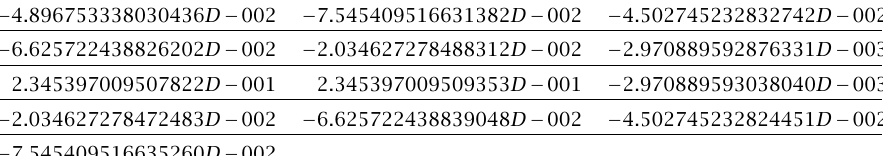
Table 3.9 . The charge distribution with n = 13 , l = 0 . 25 on γ 1 .